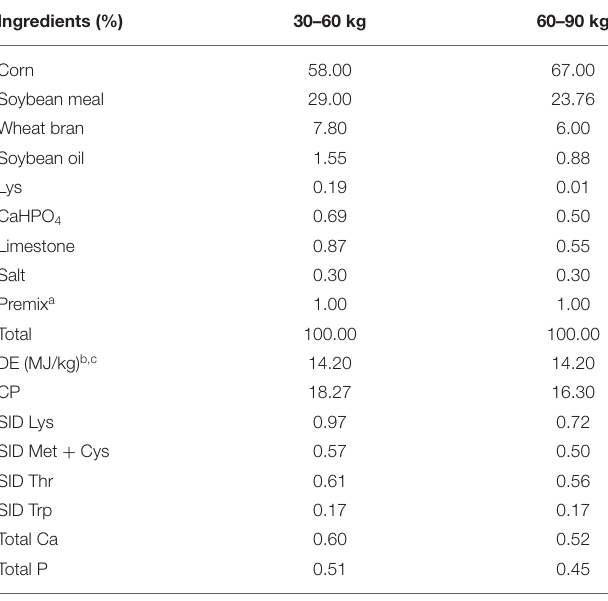
TABLE 2 | Ingredients and nutritional composition of basic